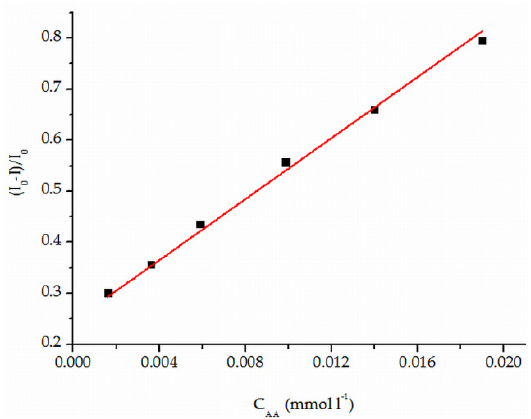
Figure 8. The calibration curve for ascorbic acid detection.